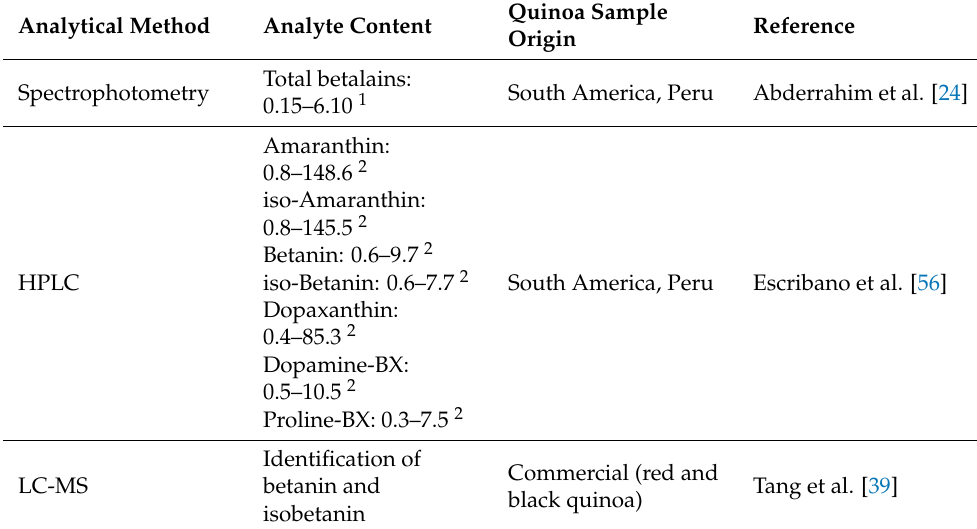
Table 4. Betalains in quinoa